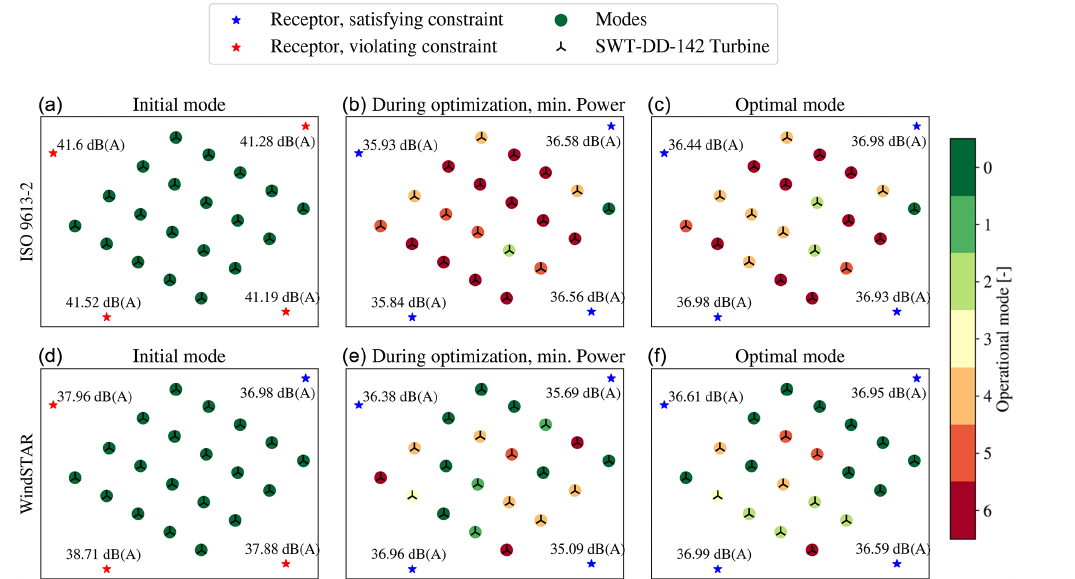
Figure 17. Scatter plots of the operational modes of the 4 × 5 SWT-DD-142 wind turbines before (a, d) , at the minimum power iteration during (b, e) and after (c, f) the optimization at θ = 0 ◦ and U 0 = 10ms − 1 . The noise constraint is set to L p , lim =